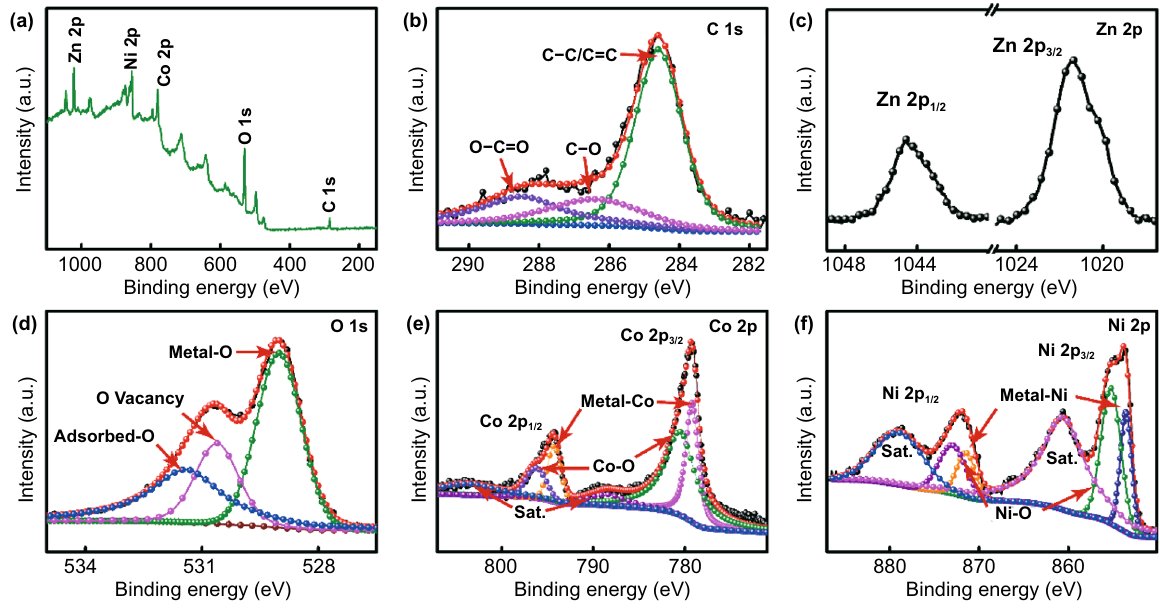
Fig. 4 a Full scan XPS spectra of S-5, b–f high-resolution spectra C 1 s, Zn 2p, O 1 s, Co 2p, and Ni 2p of